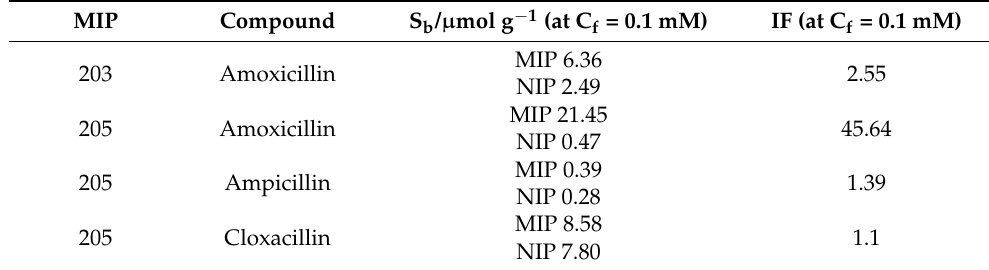
Table 3. Binding capacities (S b ) for MIP 203 (amoxicillin, ampicillin, and cloxacillin) and MIP 205 at C f = 0.1 and their corresponding imprint factors (IF). Values were drawn directly from the fitted curve of each MIP/NIP at the defined con- centration.